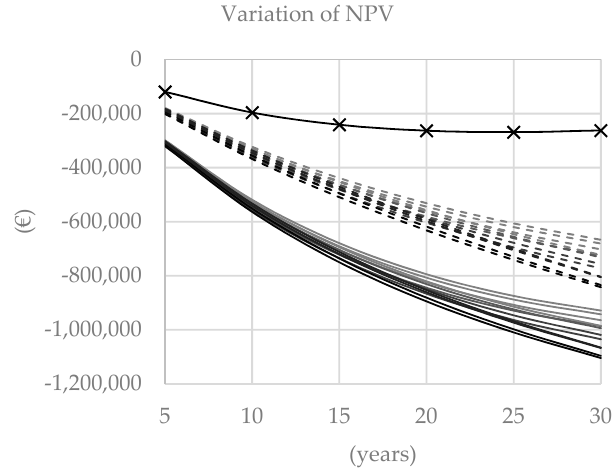
Figure 4. Interpolated and smoothed 5-year-step variation of Net Present Value in relation to di ff erent calculation periods for the four designs and the three electricity price increase scenarios. Continuous and dashed lines represent the designs with and without the BIPV, respectively. Continuous line with cross markers represents the di ff erence given by the installation of the BIPV in any of the design.